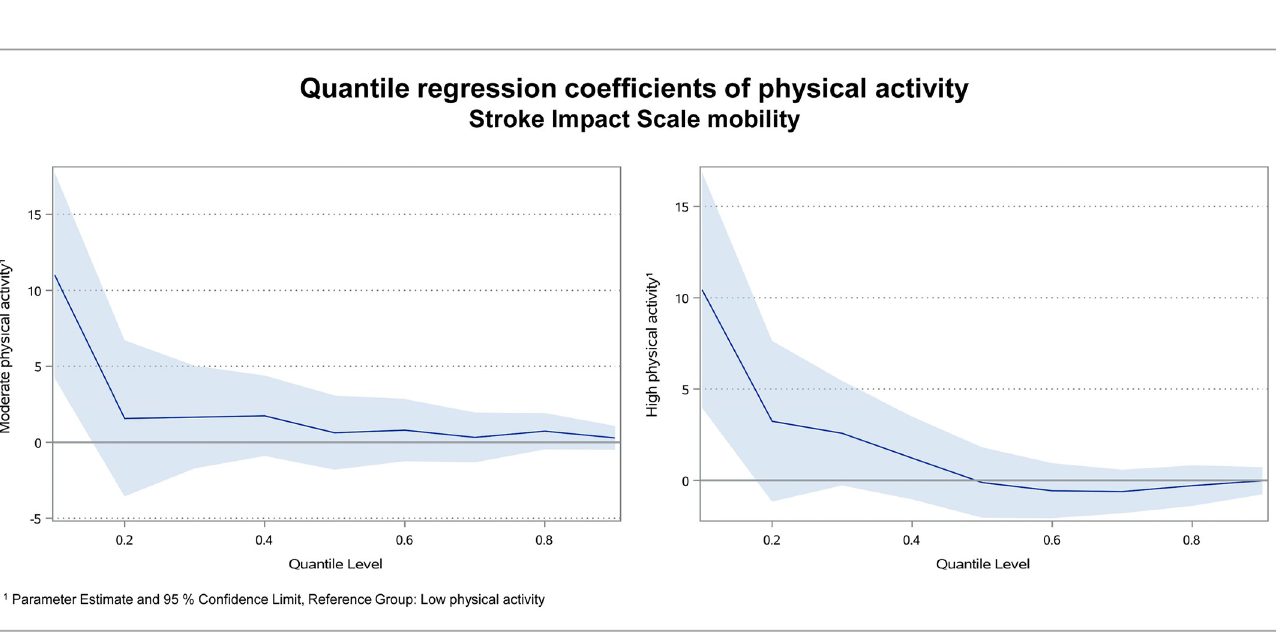
PLOS ONE | https://doi.org/10.1371/journal.pone.0266318 June 29,